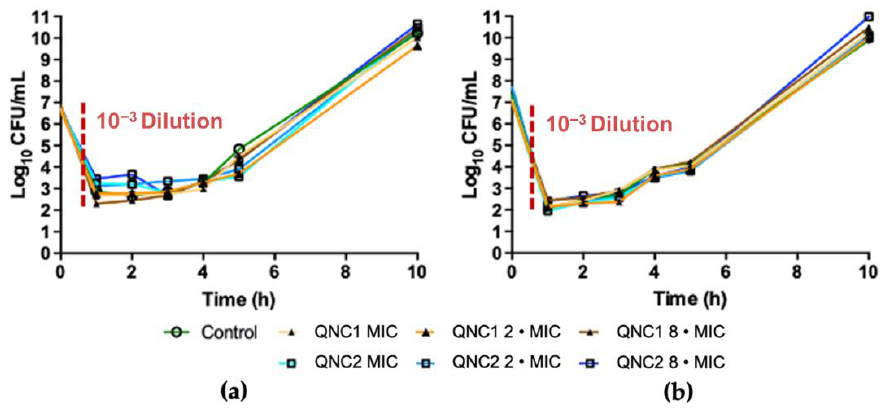
Figure 2. Post-Antibiotic Effects of QNC1 and QNC2 at MIC, 2 • MIC, 8 • MIC against; ( a ) MRSA ATCC ® 43300; ( b ) MRSA clinical isolates ISP-213.